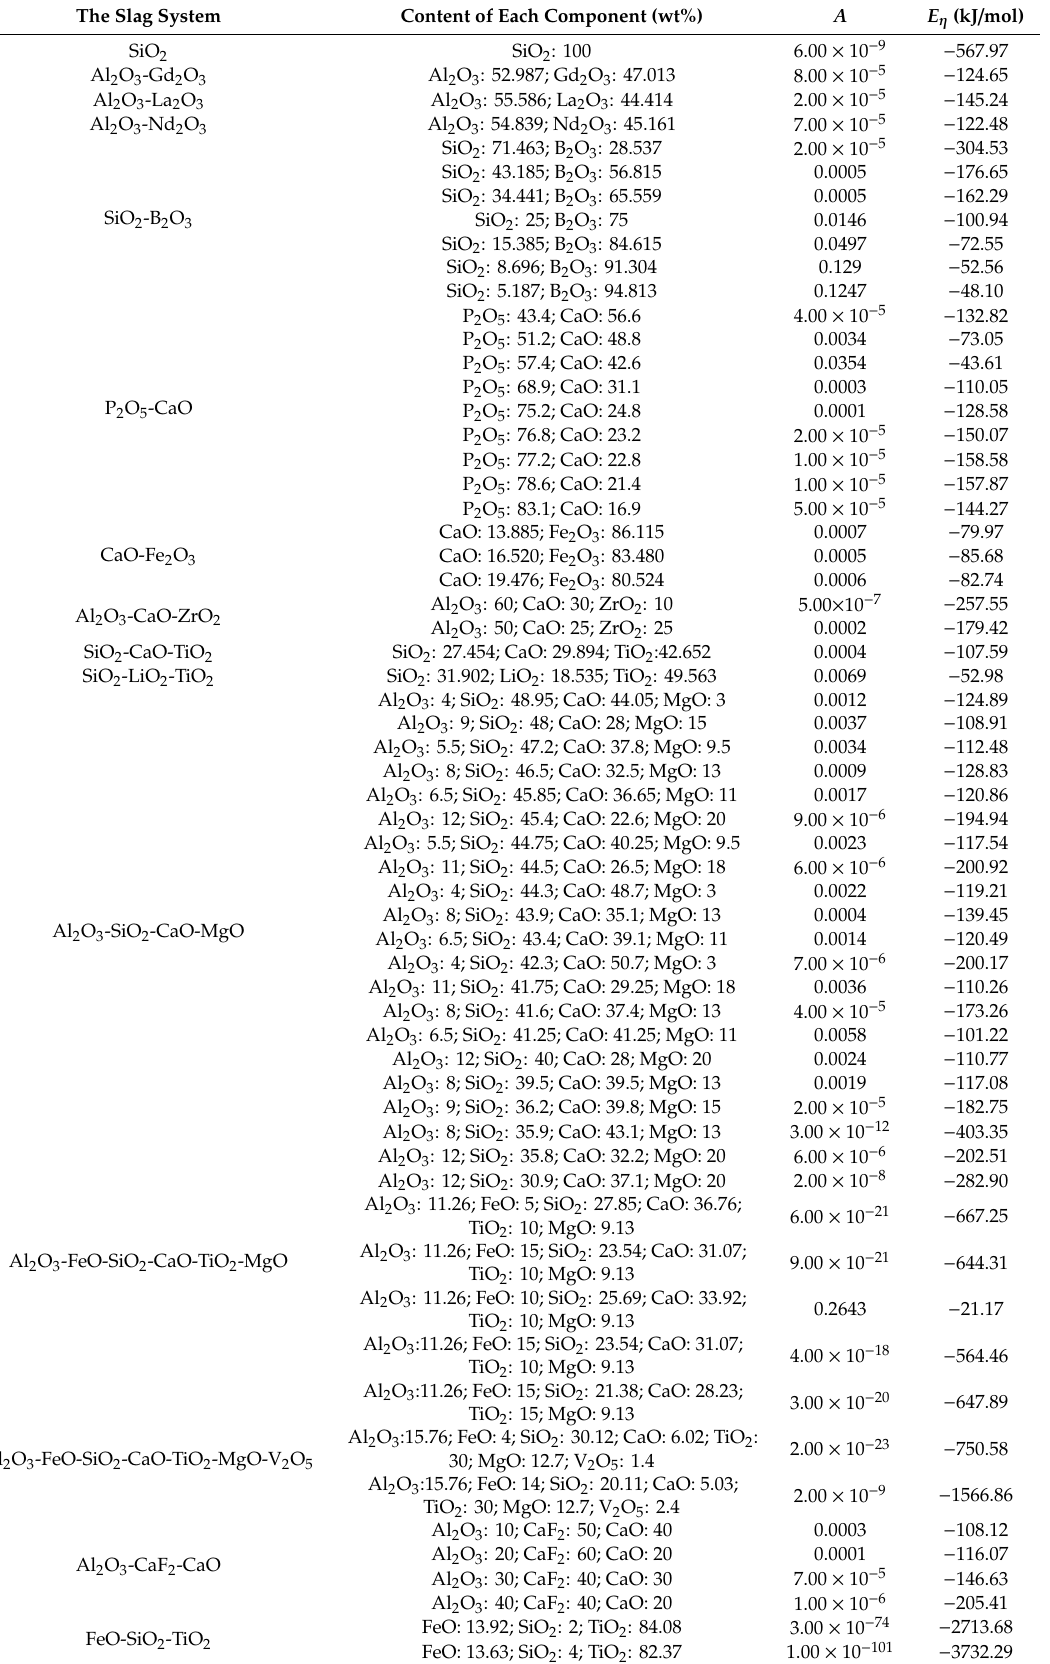
Table 5. The value of A and E η in the di ff erent slag